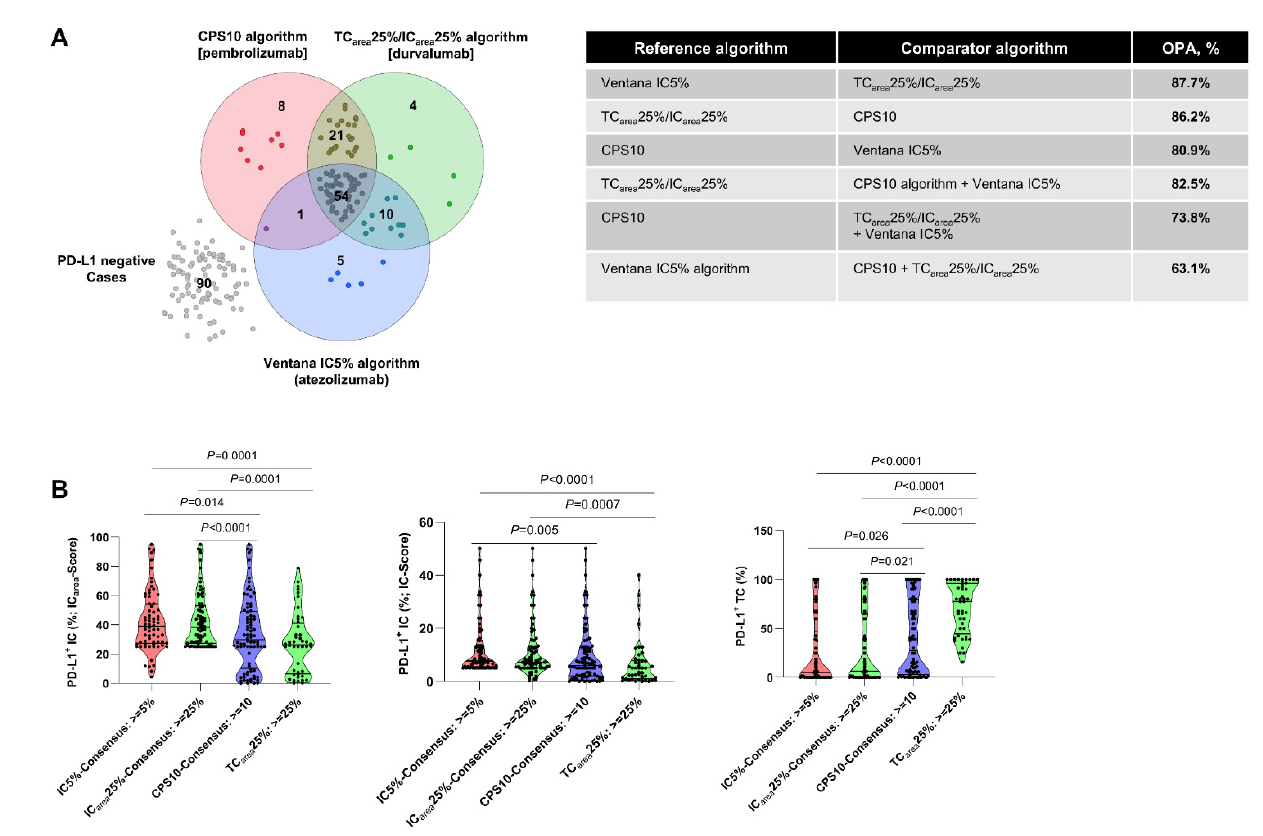
Figure 1. Agreement of different PD-L1 scoring algorithms and cut-off systems in urothelial cancer. ( A ) Left panel: Venn diagram showing the overlap of cases classified as PD-L1 positive according to the specific PD-L1 scoring algorithms. Right panel: overall percentage agreements (OPA) across different PD-L1 scoring algorithms. ( B ) Distribution of continuous consensus scoring values derived by the Ventana IC algorithm, TC area /IC area algorithm, and combined positivity score (CPS) according to specific cut ‐ off levels. Abbreviations: IC = immune cell(s); TC = tumor cell(s).